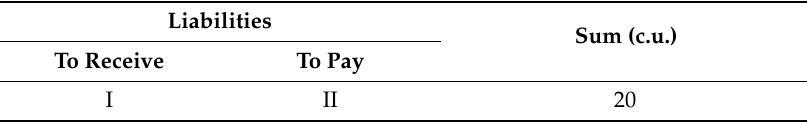
Table 2. The transaction interpretation.